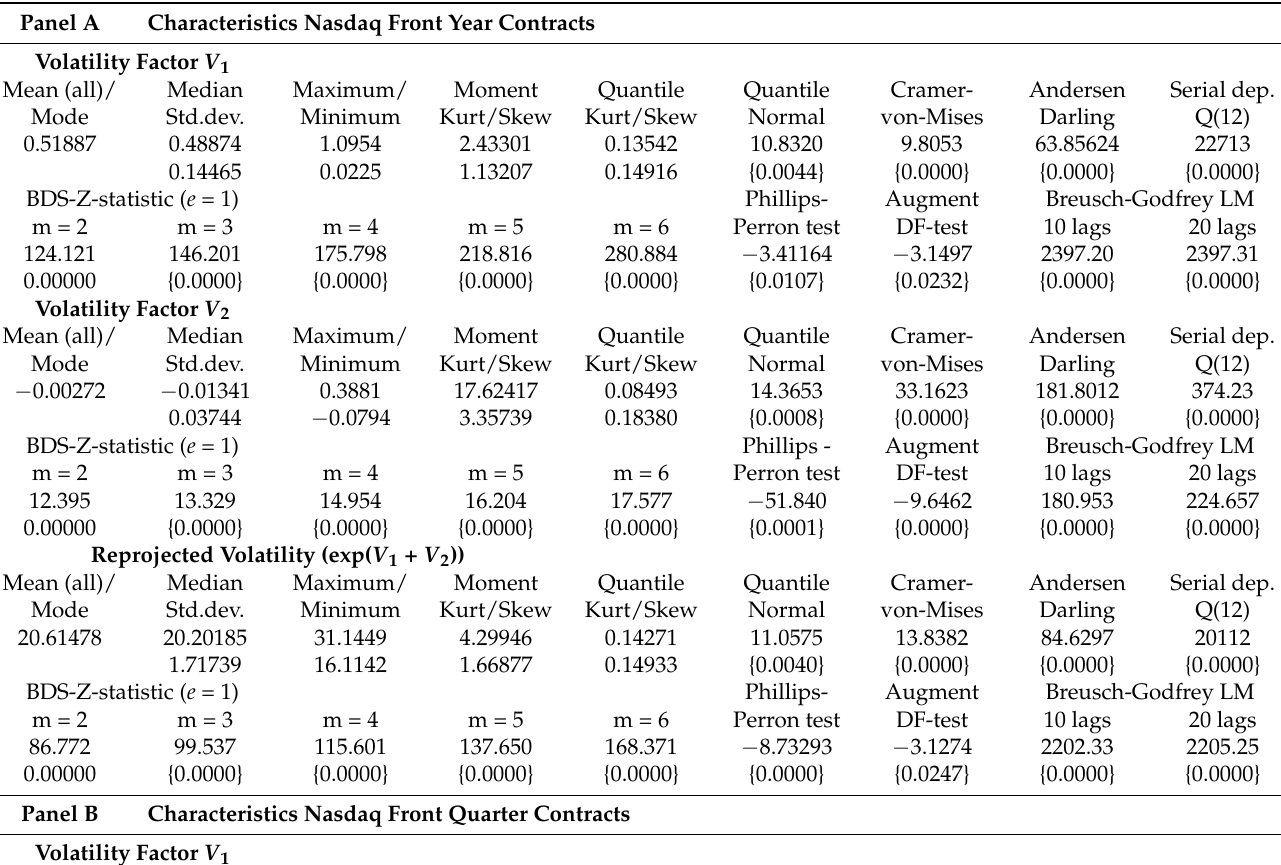
Table 3. Nasdaq OMX Front Year and Quarter Volatility Characteristics